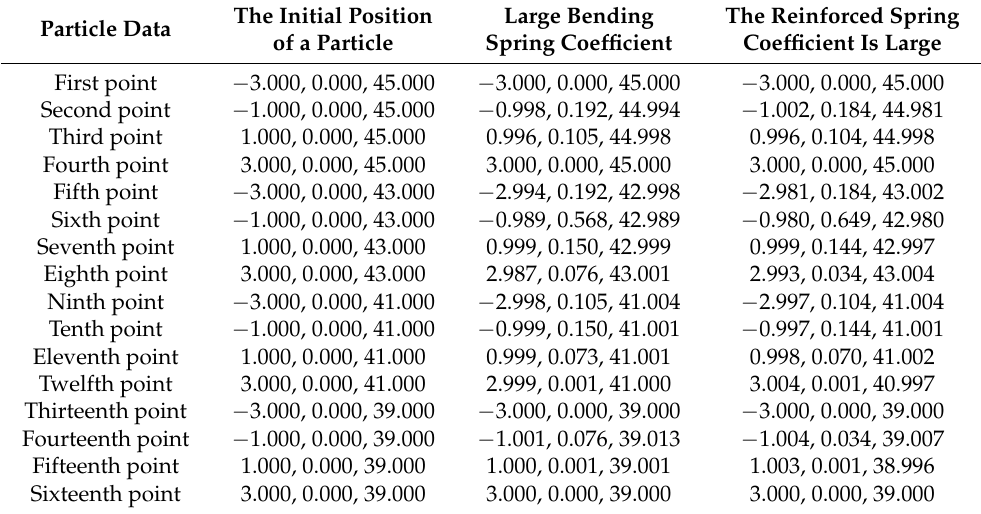
Table 6. Initial positions of the particles and the effect of springs.